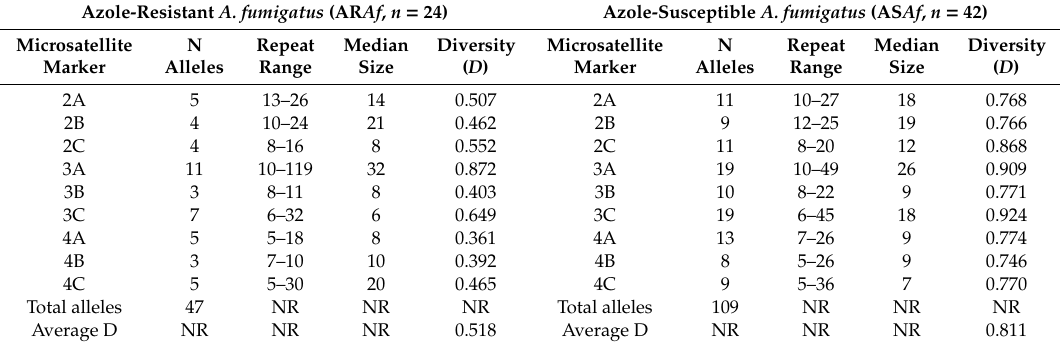
Table 2. Polymorphism information for the nine microsatellite markers obtained after short tandem repeat for A. fumigatus (STR Af ) typing of sawmill azole-resistant (AR Af ) and azole-susceptible (AS Af ) A.